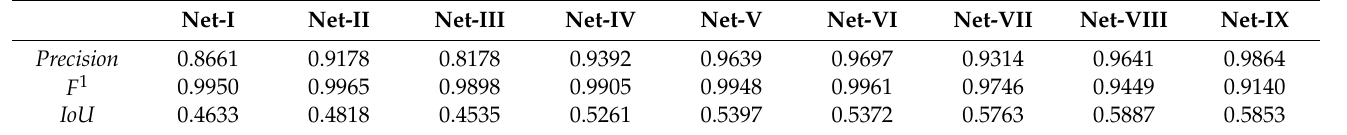
Table 18. Class metrics of cable class of testing images with the C-T ratio of 0.02.